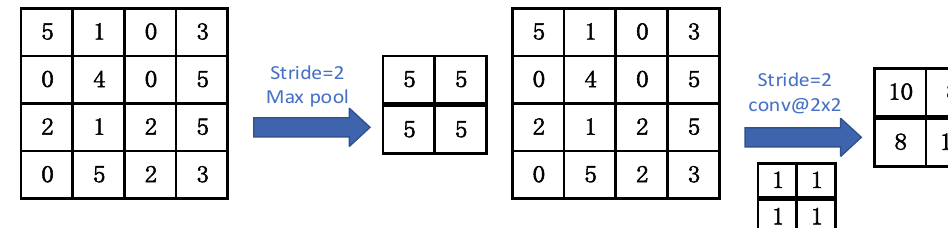
Figure 5. Comparison between pooling layer and convolution layer. Based on input and output characteristic mode of the convolution layer in FCNN and the advantages of using the convolution layer instead of the pooling layer, we design the mixed progressive convolution layers in FCNN. The large step of the convolution kernel can reduce the computational frequency and increase the network computing speed. However, if the large step is utilized continuously, some features will be lost and the recognition accuracy will be affected. However, the mixed progressive method can reduce the influence of the large step on the network recognition accuracy [28] . So we design the mixed progressive convolution layer structure, as shown in Figure 6.